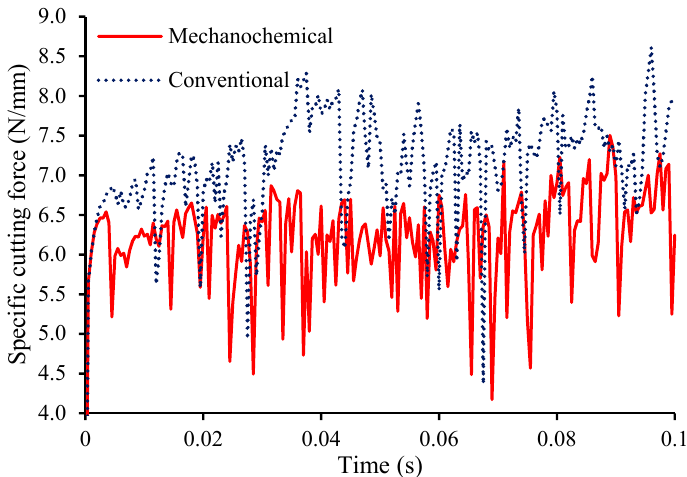
Figure 14. Plot of the theoretical specific cutting forces under conventional cutting conditions and with the mechanochemical effect.